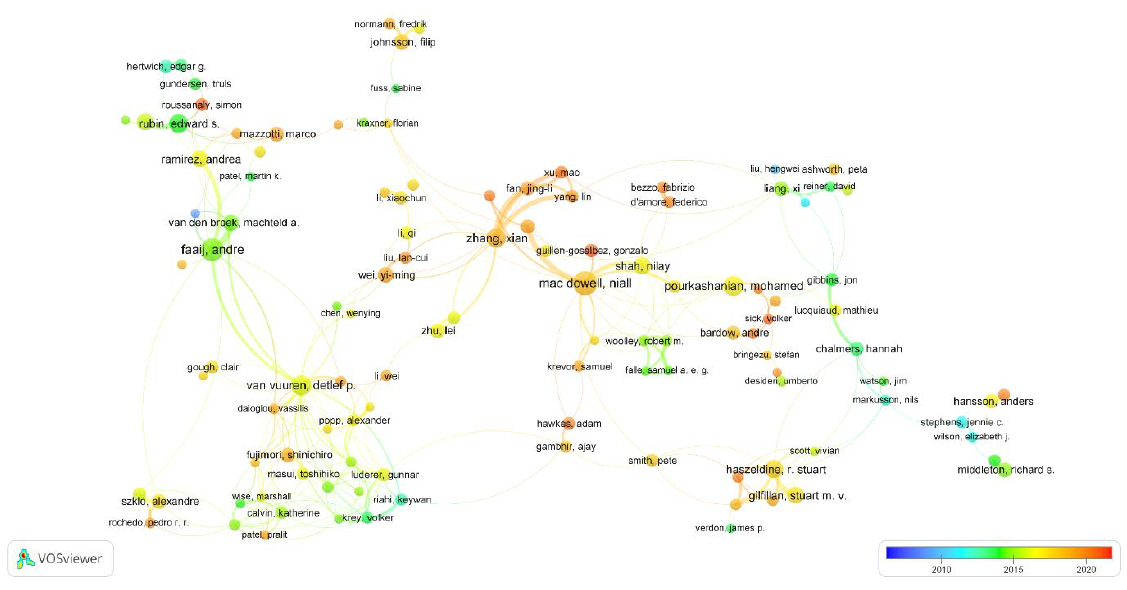
Figure 6. Network visualization map of international researcher’s collaboration on carbon capture and utilization with a minimum of 5 publications.